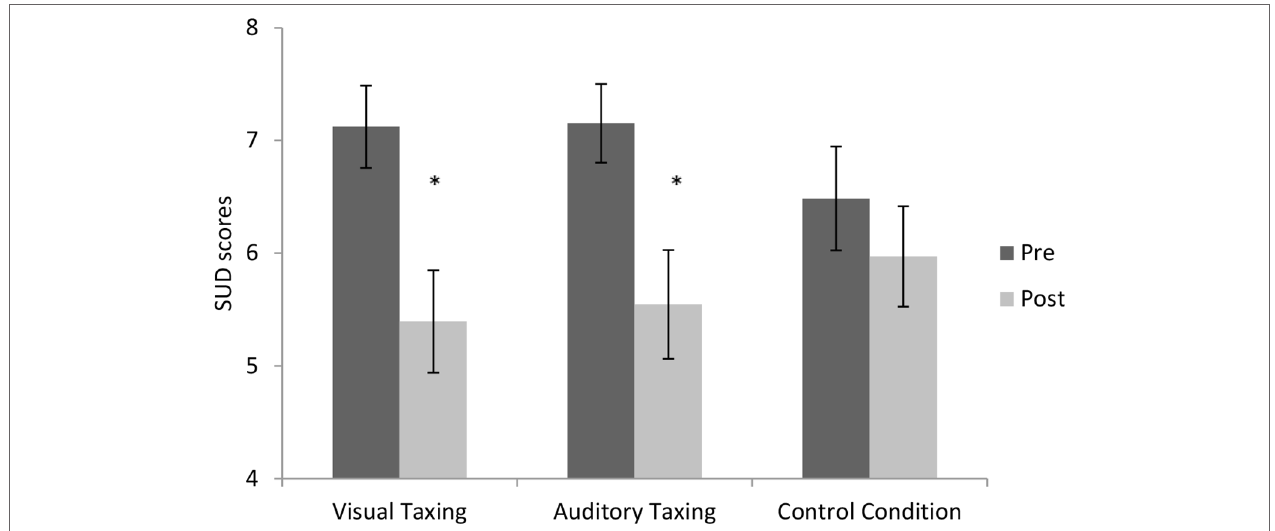
FIGURE 2 | Pre- and post SUD scores per condition. Error bars depict +-1 S.E.M. (* = p < .05) (SUD, Subjective Units of